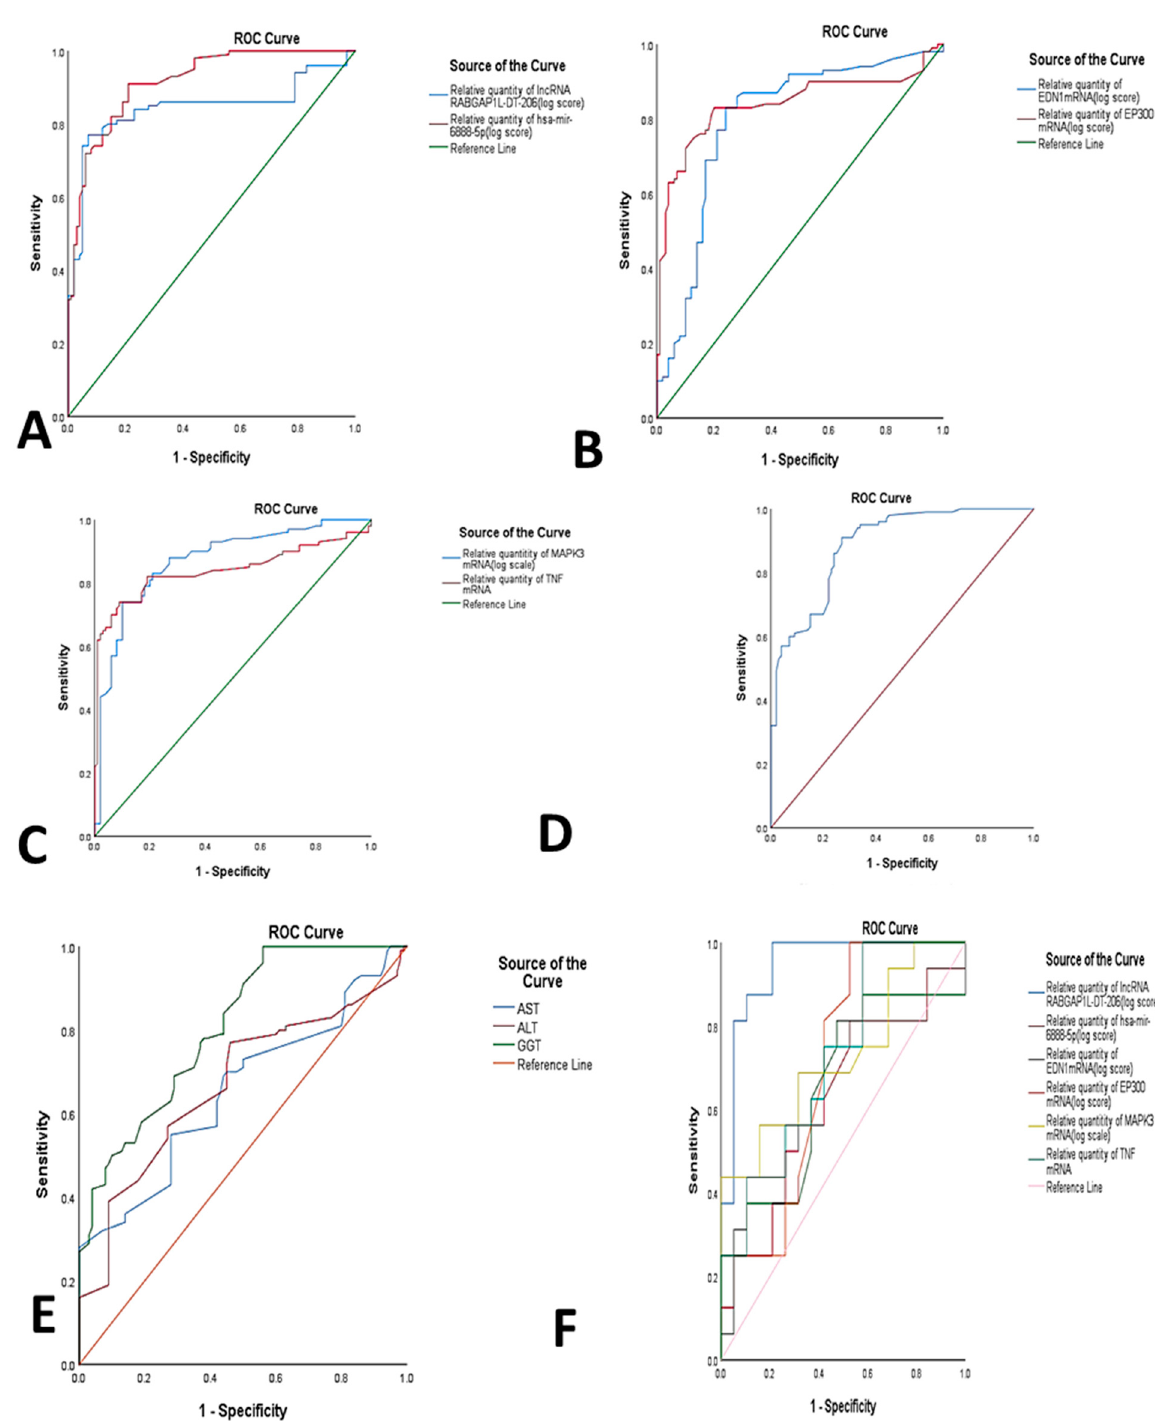
Figure 3. ROC curve analysis of ( A ) lncRNA RABGAP1L-DT-206, hsa-miR-6888-5p between NAFLD/NASH and con- trols; ( B ) EP300 mRNA, EDN1 mRNA between NAFLD/NASH and controls; ( C ) TNF mRNA, MAPK3 mRNA between NAFLD/NASH and controls. ( D ) Combined RNAs panel between NAFLD/NASH and controls ( E ) ALT, AST, GGT between NAFLD/NASH and controls; ( F ) lncRNA RABGAP1L-DT-206, hsa-miR-6888-5p, EP300 mRNA, EDN1 mRNA, TNF mRNA; and MAPK3 mRNA panel between group A and B.